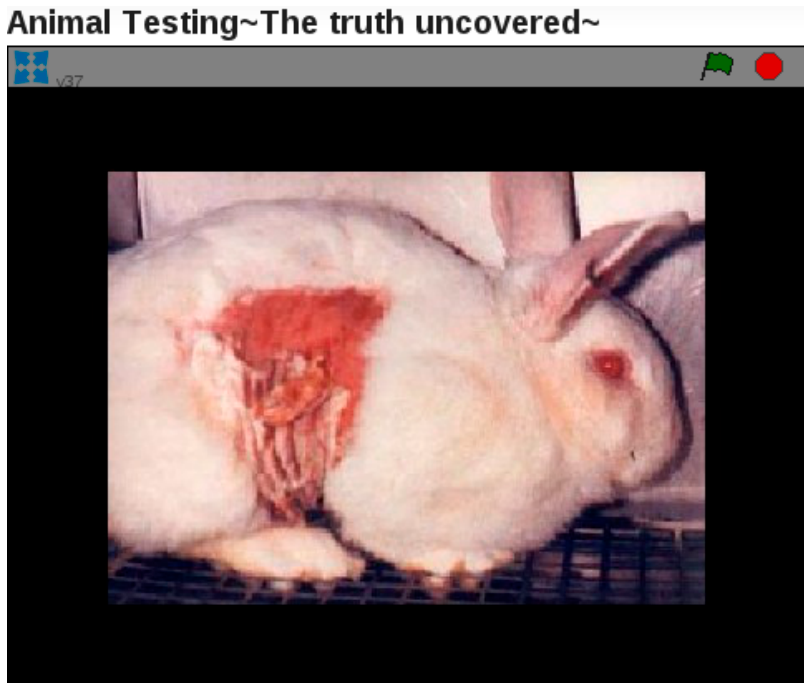
Figure 5. Scratch project raising awareness on animal testing.